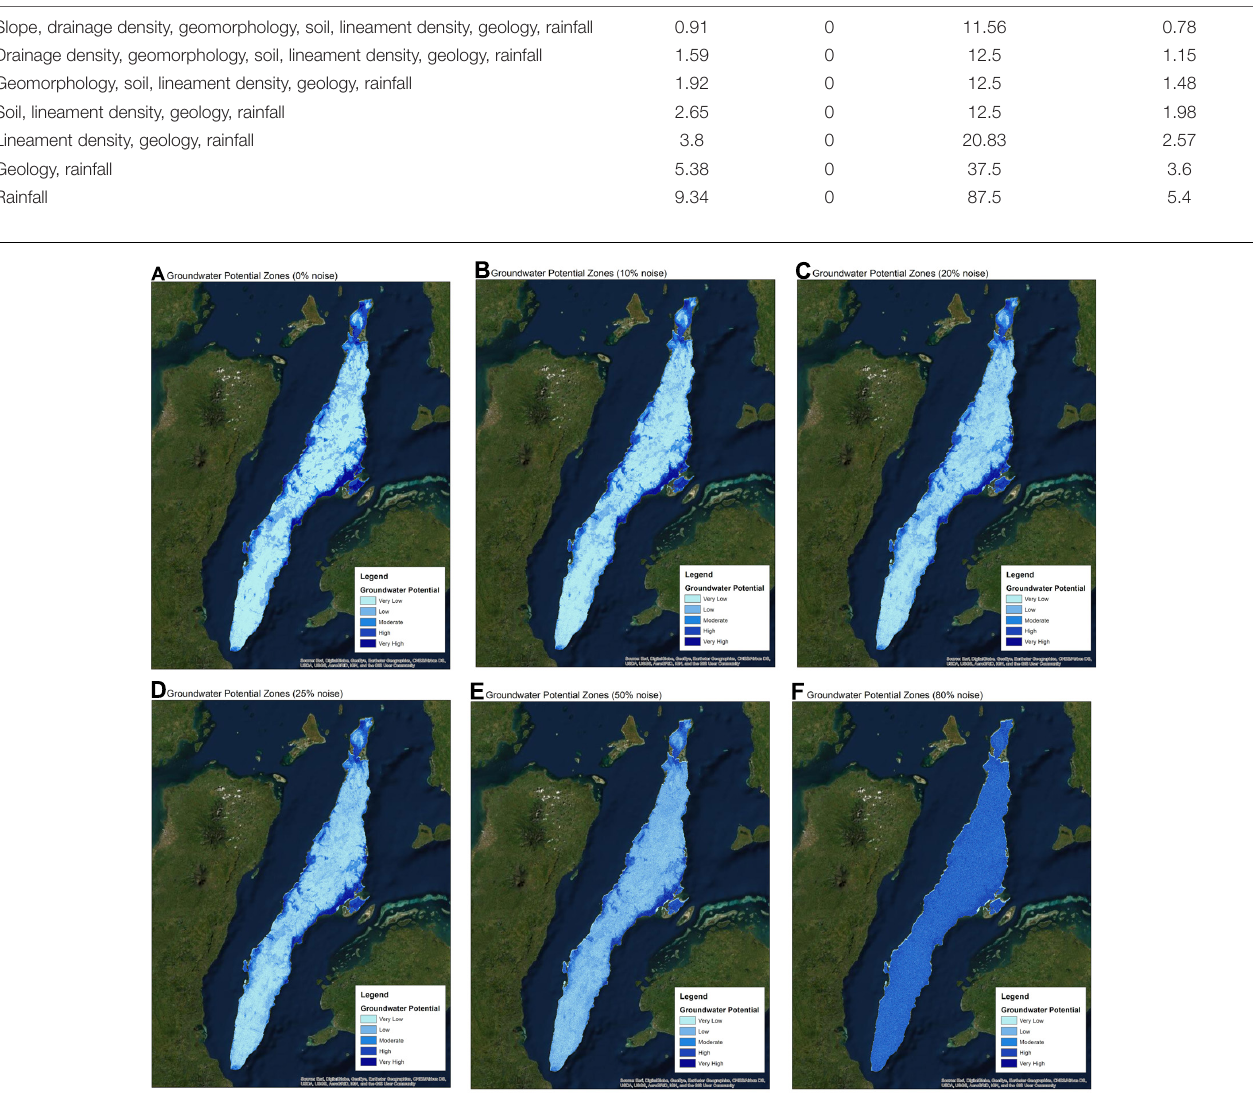
FIGURE 3 | The GWP output maps at different noise levels according to K -values. Top row: (A) K = 0%, (B) K = 10%, (C) K = 20%. Bottom row: (D) K = 25%, (E) K = 50%, and (F) K = 80%. Basemap Source: ESRI (2018), DigitalGlobe, GeoEye, Earthstar Geographics, CNES/Airbus DS, USDA, USGS, AeroGRID, IGN, and the GIS User